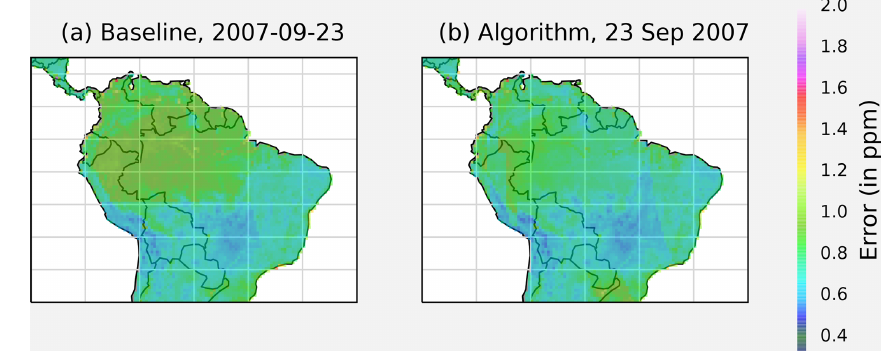
Figure 10. There is a significant improvement in predicted errors over the Amazon for the autumn equinox.